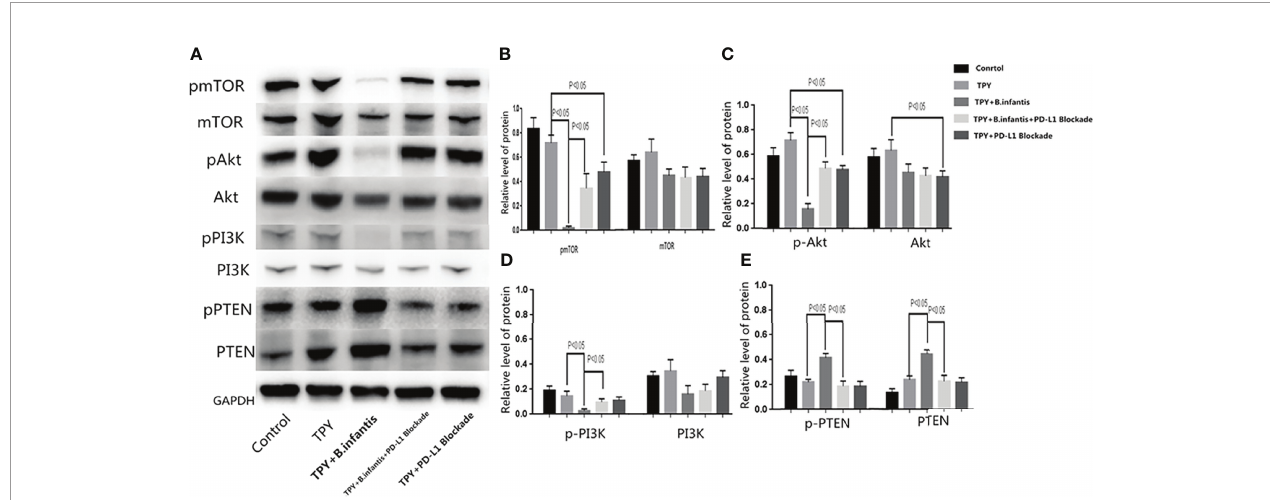
FIGURE 5 | Effect of B. infantis supernatant on the PI3K-Akt-mTOR pathway after the blocking of PD-L1. (A) mTOR, Akt, PI3K, PTEN phosphorylated protein and total protein expression. (B) A statistical chart showing the p-mTOR and mTOR protein expression difference. (C) A statistical chart showing the p-Akt and Akt protein expression difference. (D) A statistical chart showing the p-PI3K and PI3K protein expression difference. (E) A statistical chart showing the p-PTEN and PTEN protein expression difference. The data in the fi gure are expressed as mean ± standard deviation, and the sample comparison among the groups was conducted using one-way ANOVA. P < 0.05 was considered statistically signi fi